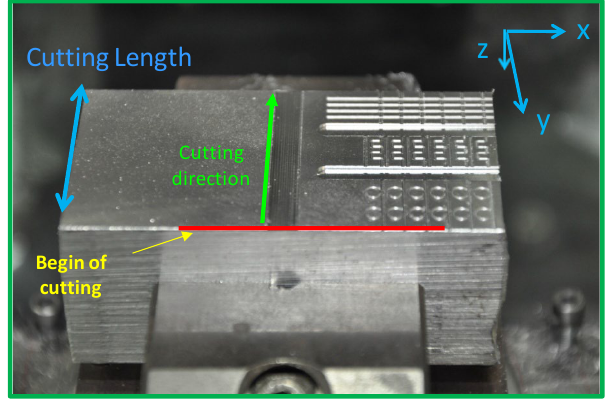
Figure 3. Implementation of the cutting test for the micro milling process. Table 1. Cutting conditions.